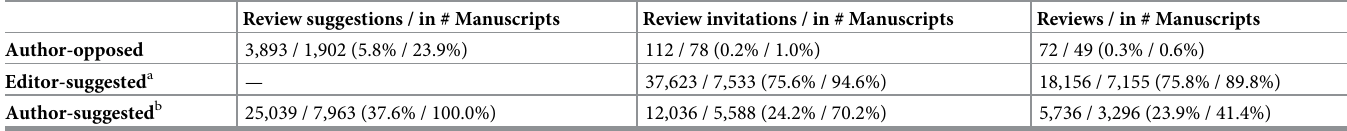
Table 2. Breakdown of reviews and manuscripts per type of reviewer. Percentages are calculated as the fraction of total number of review suggestions/review invita- tions/reviews, and manuscripts where such information appears per type of reviewer. For example, the first cell (i.e., 5.8% / 23.9%) means author-opposed reviewers were suggested in 5.8% of all review suggestions involving 23.9% of all manuscripts. Similarly, the second cell (i.e., 0.2% / 1.0%) means that author-opposed reviewers were invited to 0.2% of all invitations involving 1.0% of all manuscripts.